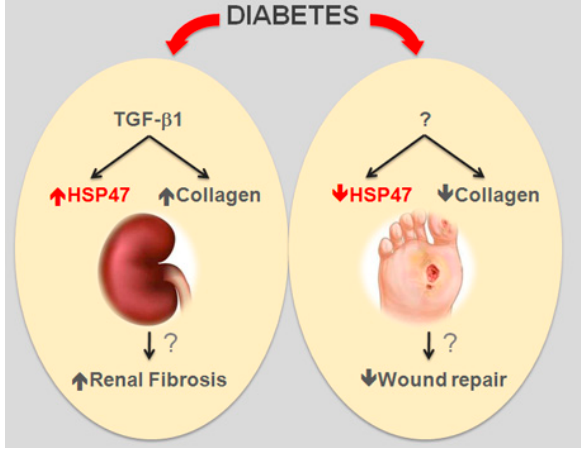
Figure 1. Role of HSP47 in Diabetic Complications. The collagen-specific chaperon HSP47 is overexpressed (up arrow) in experimental diabetic nephropathy and downregulated (down